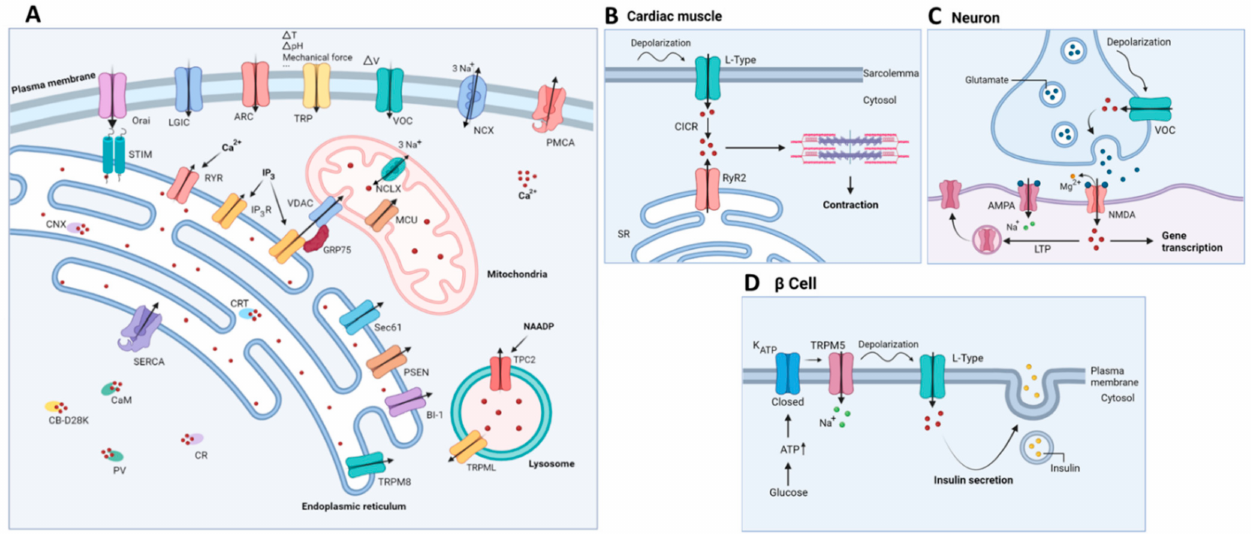
Figure 1. ( A ) Schematic representation of the Ca 2+ -signaling toolkit. Ca 2+ can enter the cell